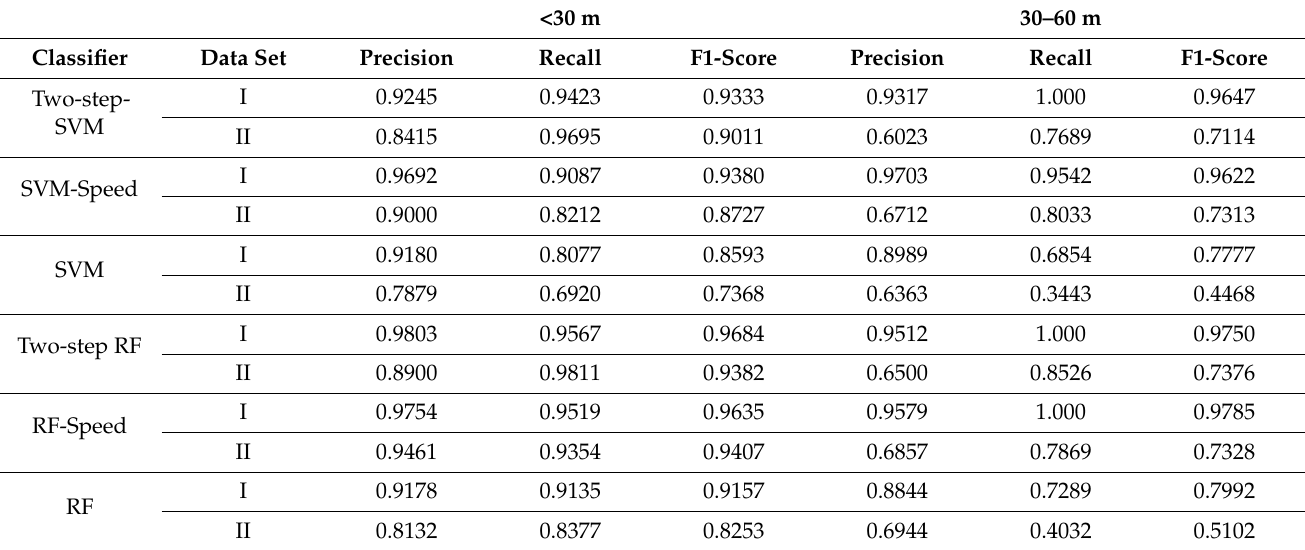
Table 7. Quality of pedestrian detection at the different ranges from the